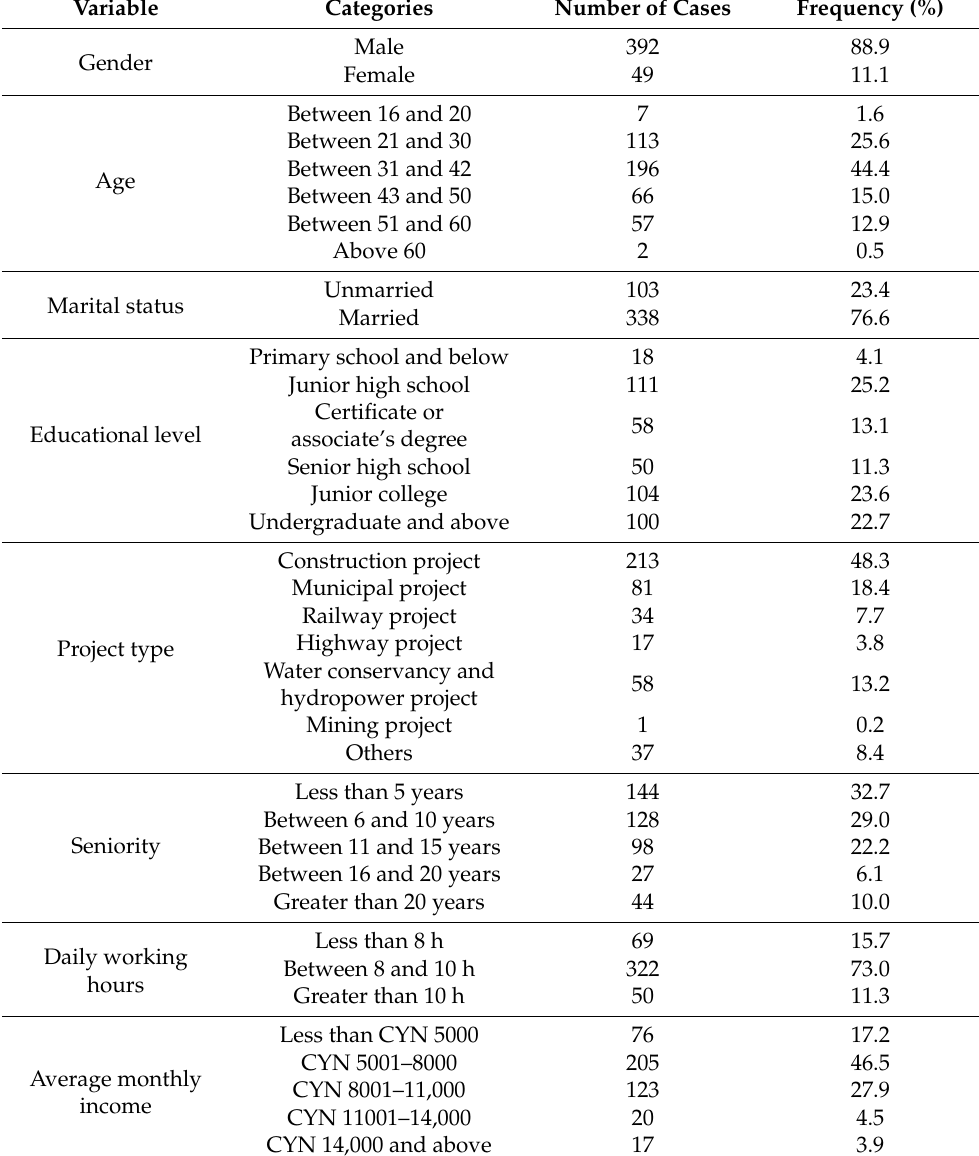
Table 1. Demographic information of respondents (N =